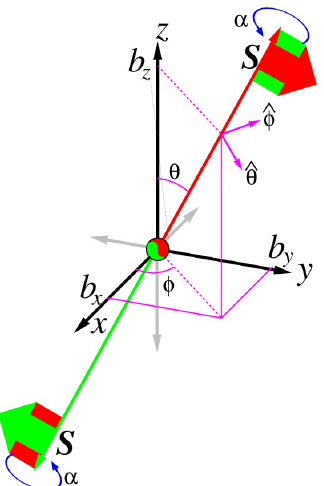
Figure 7. The CPT invariance is the fundamental symmetry of physical laws under transformations involving simultaneous inversion of charge, parity, and time. The CPT theorem proves a strict correspondence between matter and antimatter. In particular, a particle and an antiparticle have the same mass and magnetic moment. Their electric charges are equal in modulus and opposite in sign, and their spins are equal in modulus and opposite in direction. According to the CPT theorem, two paired fermions with mirror half-integer spins S can form a long-lived Bose-particle with integer spin. Here the half-integer spin s = cos ( α /2 ) + ( b x e x + b y e y + b z e z ) sin ( α /2 ) can be seen as a pseudovector ( b x , b y , b z ) equipped with a flag that turns around the flagstaff on an angle α